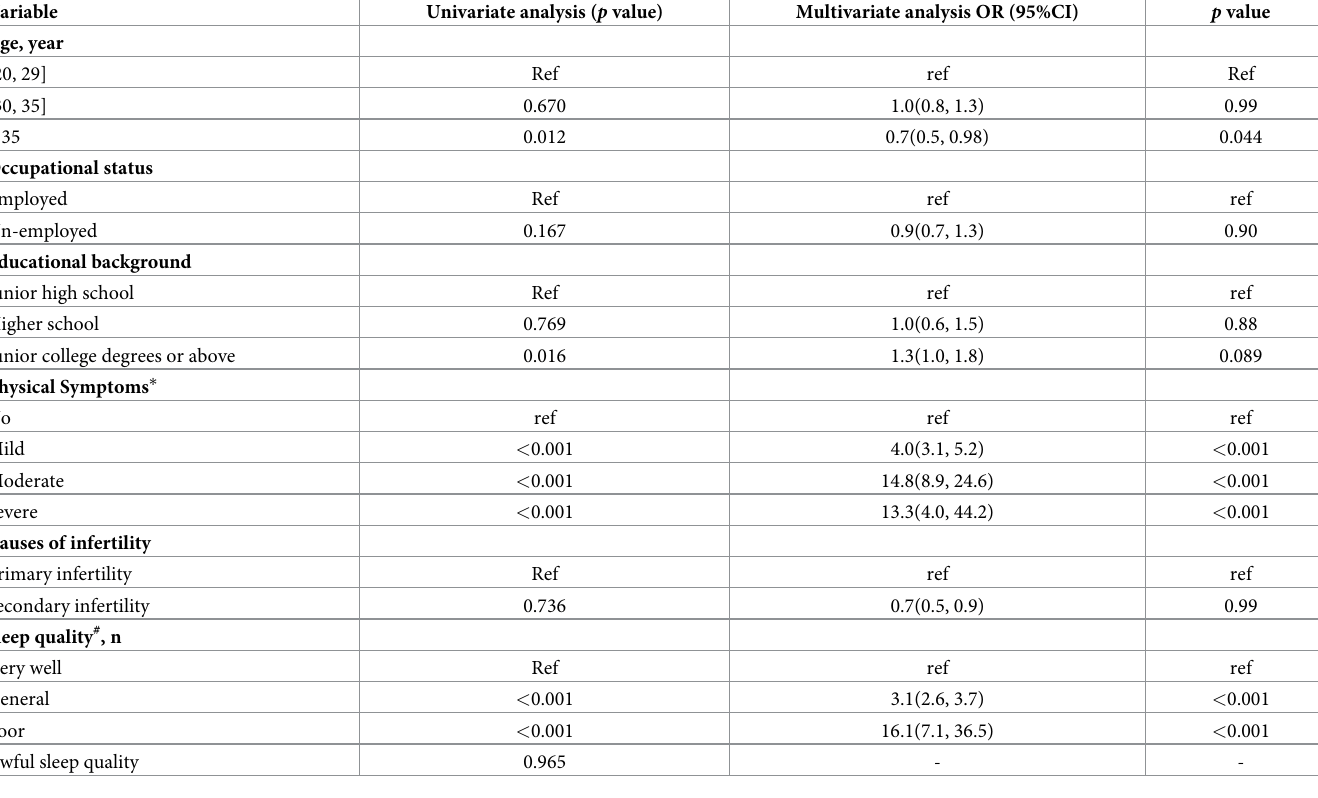
Table 3. Univariate analysis and multivariate logistic regression analysis of the depression in infertile